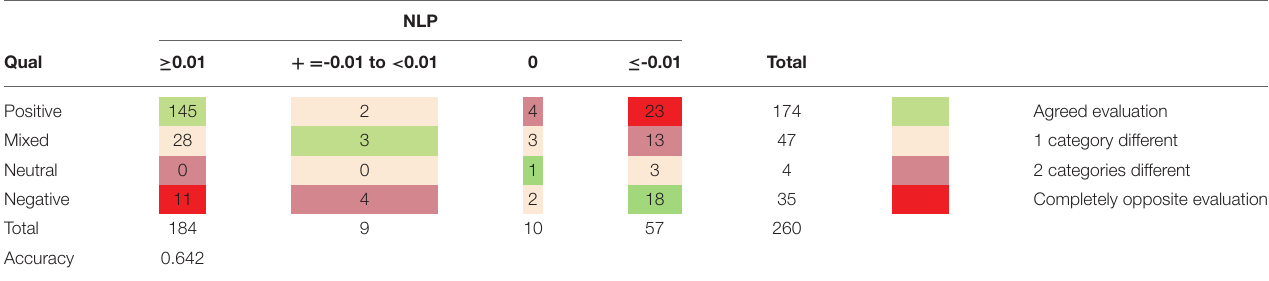
TABLE 6 | Sentiment analysis confusion matrix [ ±